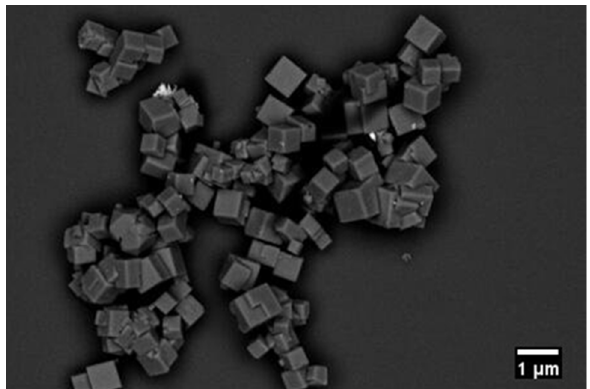
Figure 10. SEM image of pyrite after desorption experiment in a solution of 50 ppm CTAB.